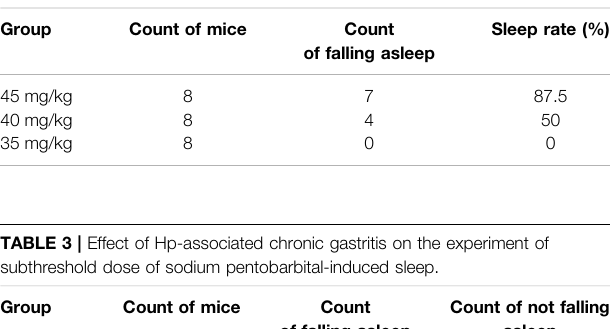
TABLE 2 | Grope of subthreshold dose of sodium pentobarbital-induced sleep. Group Count of mice